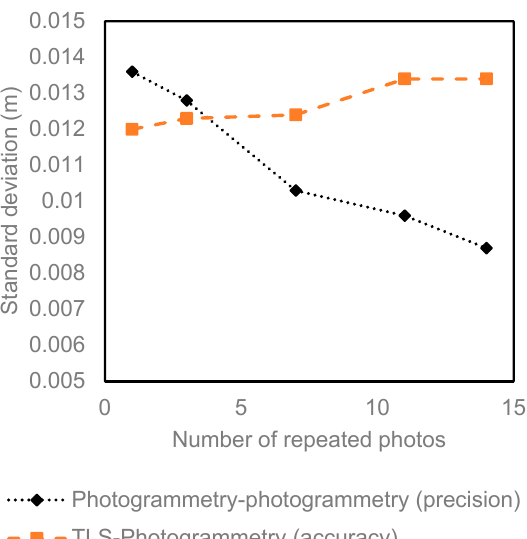
Figure 10. Comparison of models constructed with repeated photographs to TLS and to photogrammetry.